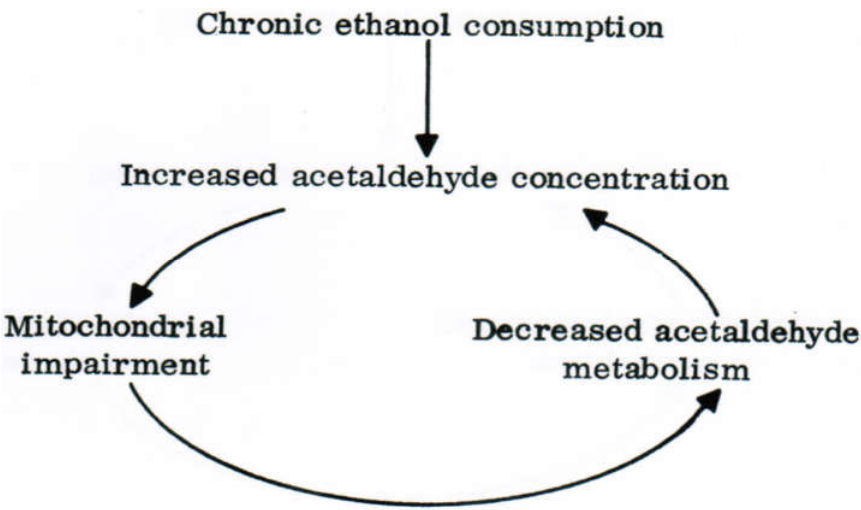
Figure 6. Hypothesis of a vicious circle of acetaldehyde in the liver. Acetaldehyde is increasingly generated from ethanol through MEOS, which is adaptively induced in activity following chronic ethanol consumption. Increased acetaldehyde levels in the liver in turn impair mitochondrial functions, including the activity of mitochondrial acetaldehyde dehydrogenase, which again likely enhances hepatic acetaldehyde concentrations at least temporarily, representing a vicious circle.